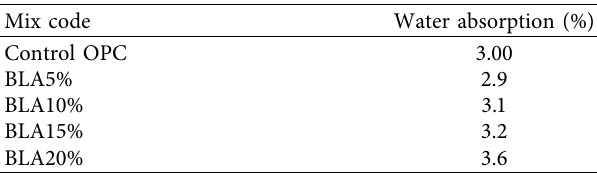
Table 12: Water absorption of BLA-blended cement